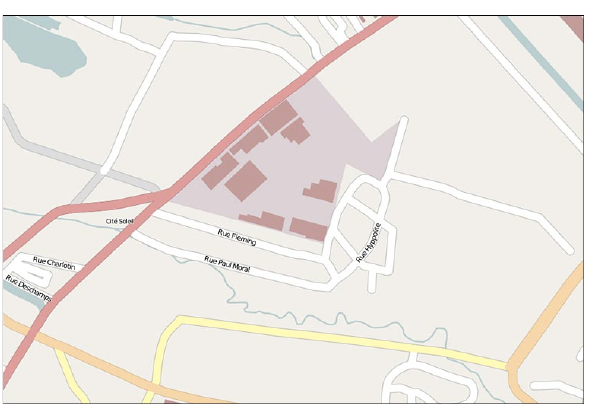
Figure 2. OSM Map of Port-au Prince before the quake